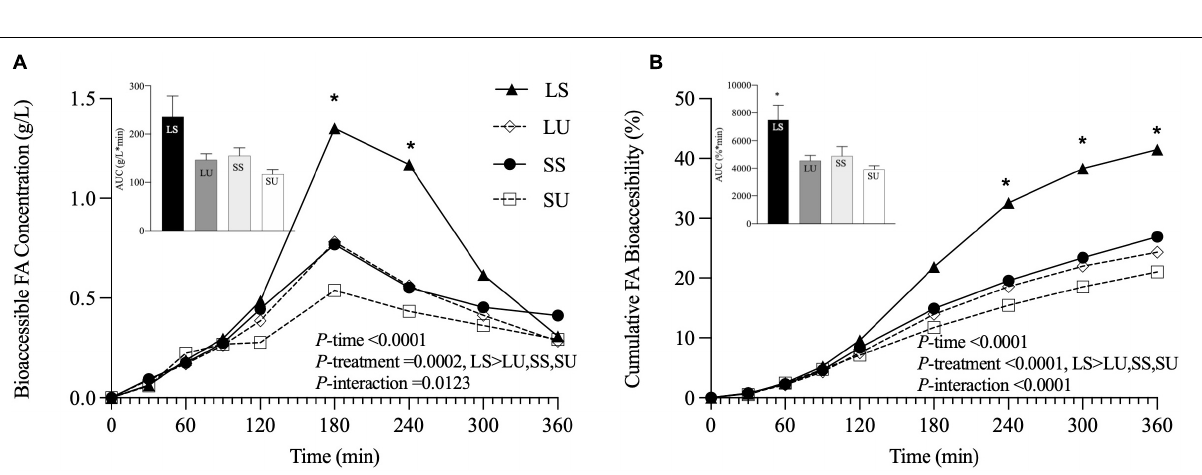
Frontiers in Nutrition |